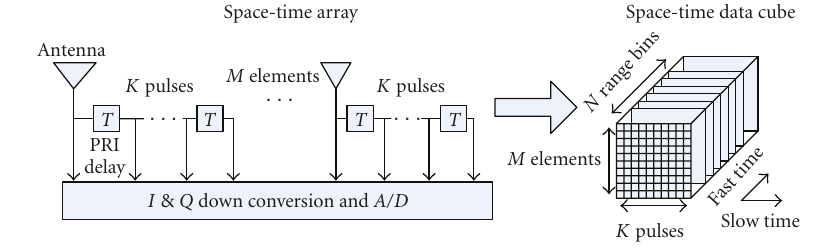
Figure 2: Space-time array radar data cube generation.